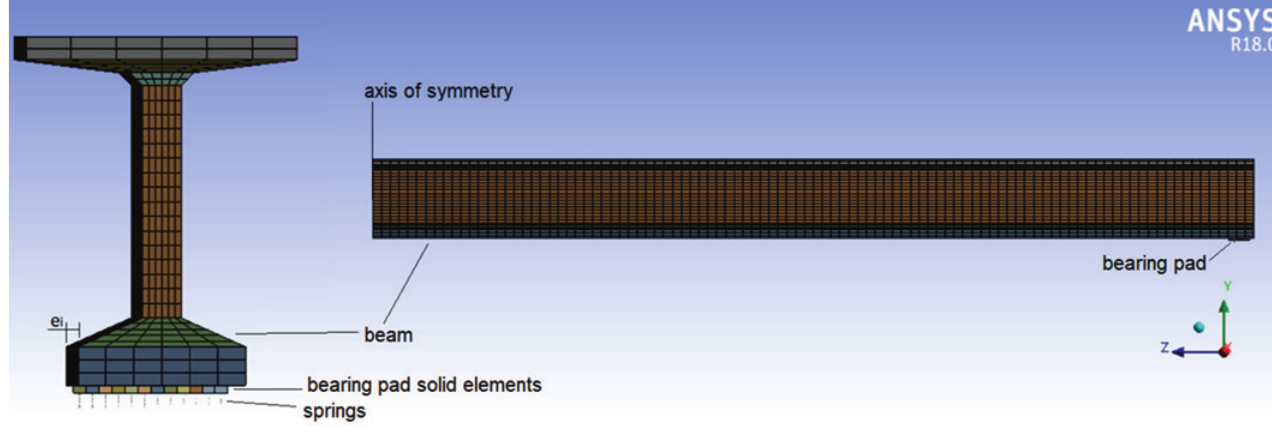
Cross section of the beam on bearing pads and symmetrical longitudinal